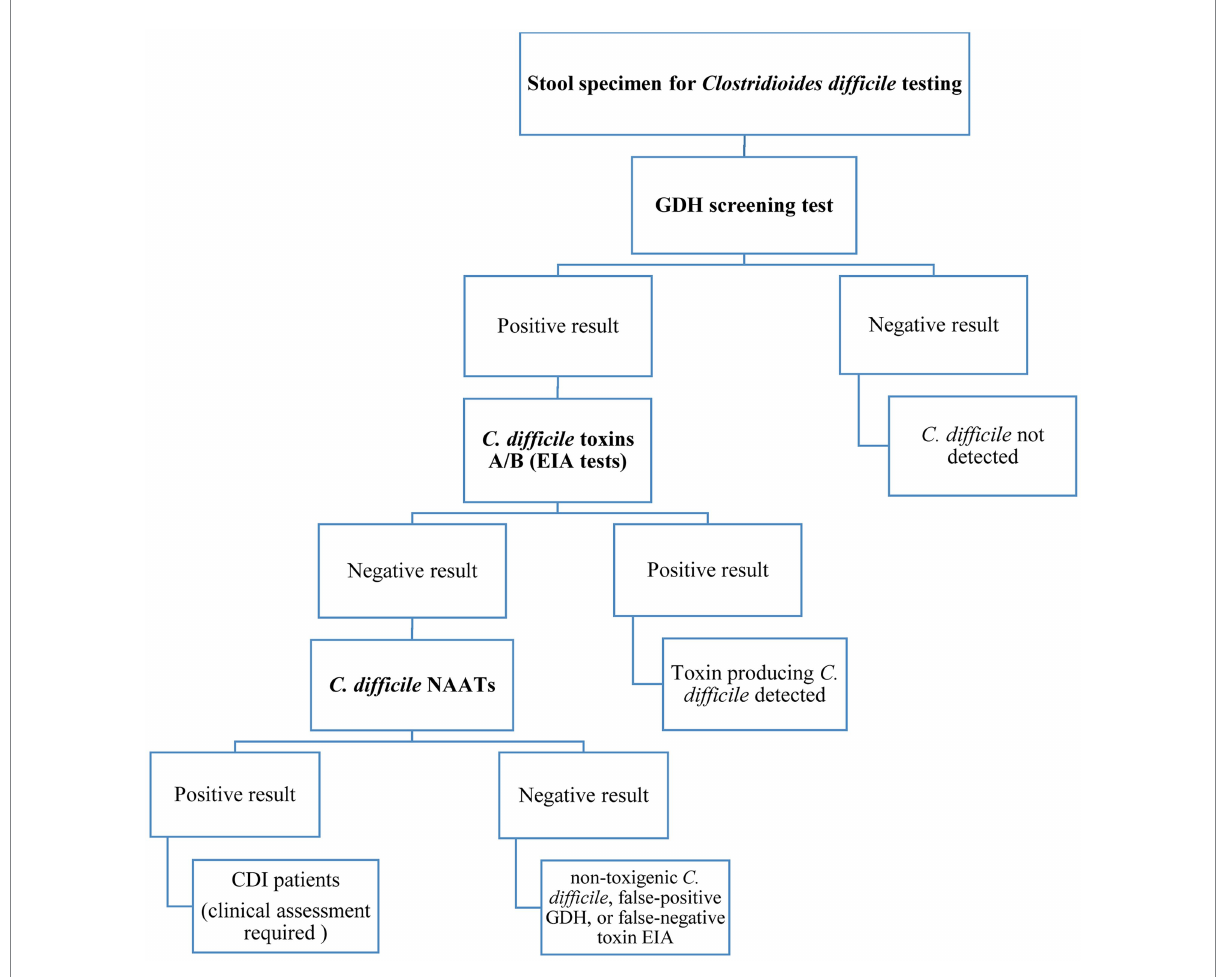
FIGURE 1 Three-step algorithm for diagnosis of Clostridioides difficile infection.